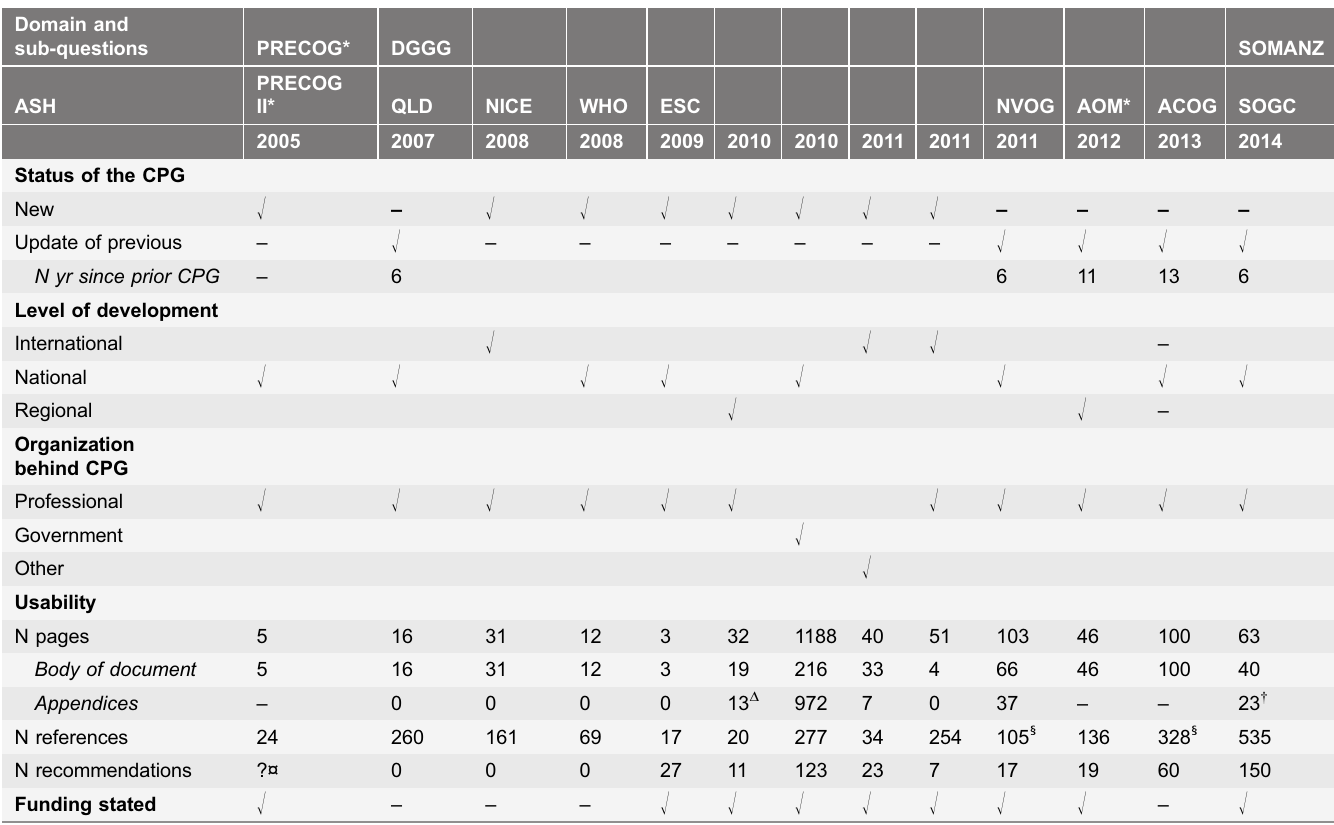
Table 1. General description of included Clinical Practice